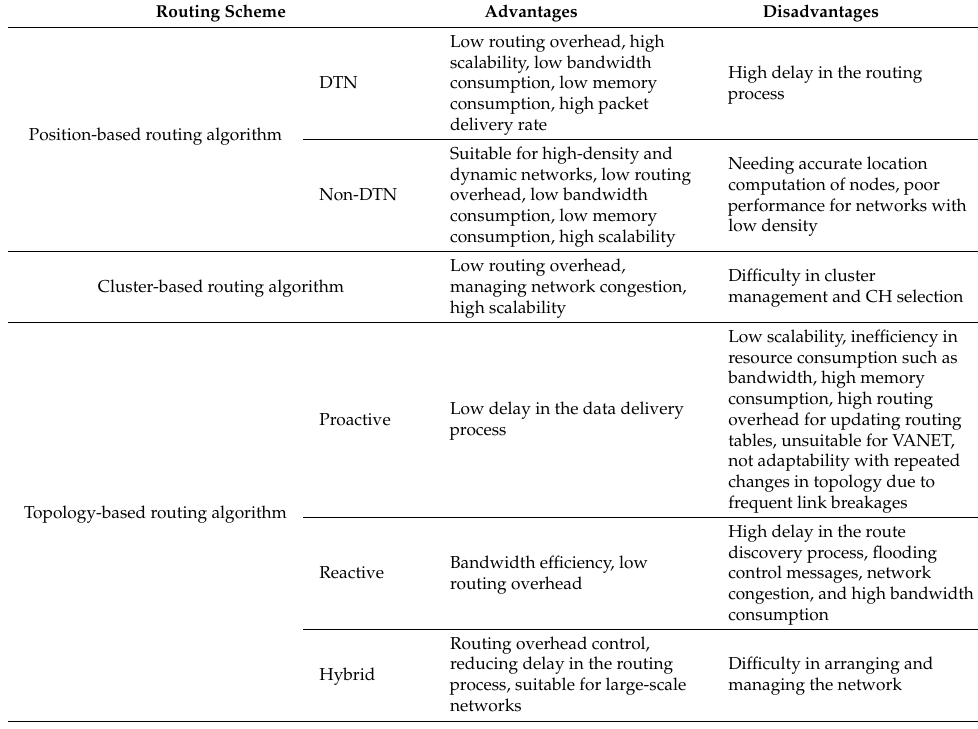
Table 7. Comparison of different routing